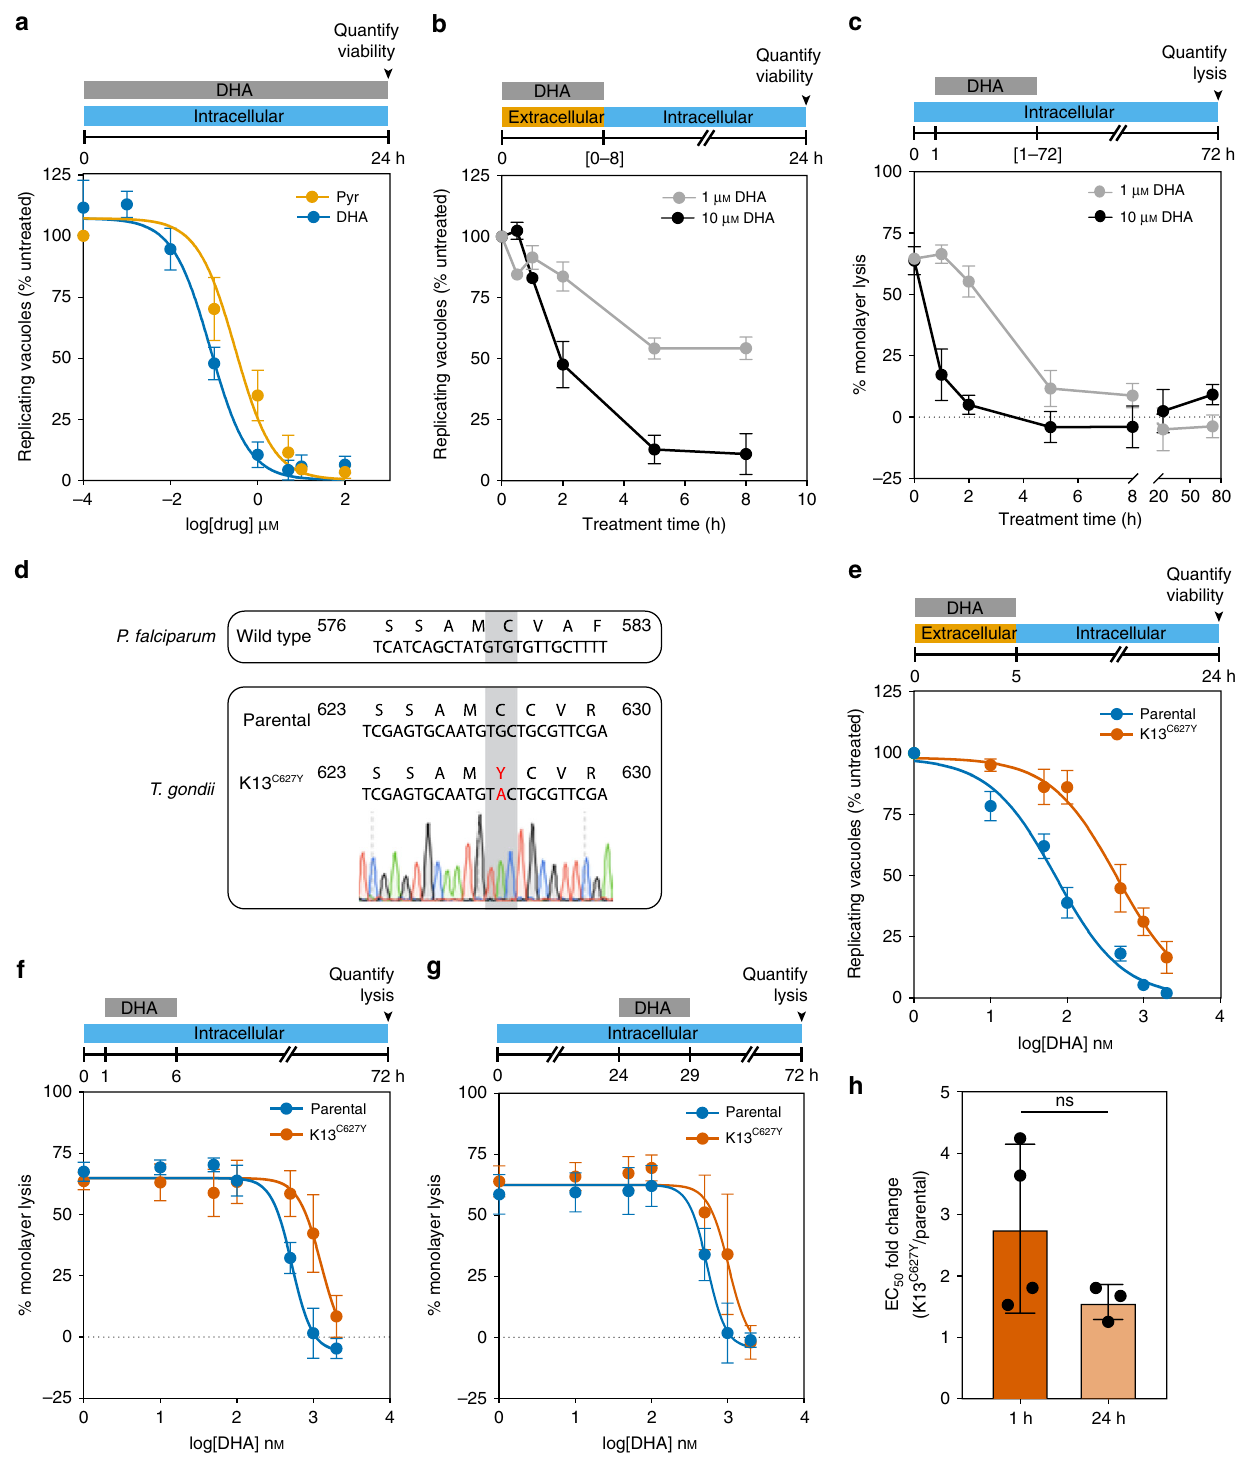
population; Fig. 2a). Guides against a single gene (TGGT1_228110) were substantially depleted under drug treat- ment compared to the untreated control (Fig. 2b and Supple- mentary Data 1). TGGT1_228110 encodes a previously unstudied T. gondii gene with three to four transmembrane domains, pre- dicted to be dispensable under standard growth conditions 34 . Structural prediction using HHPred 47 indicated that TGGT1_228110 is homologous to TMEM14C ( p = 5 × 10 − 21 ), a recently identi fi ed porphyrin transporter found in mammals 48